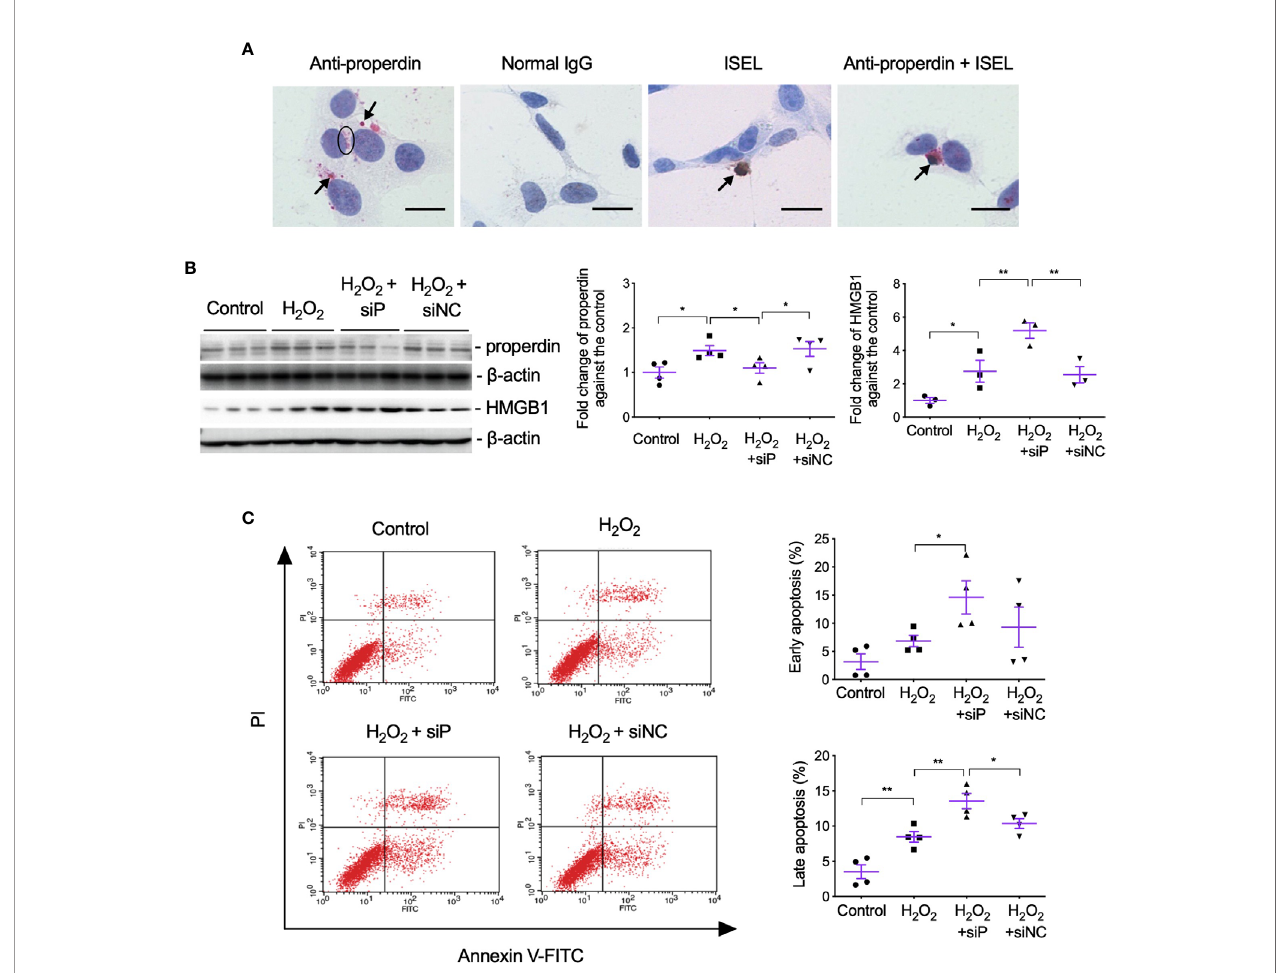
FIGURE 6 | Properdin tagged apoptotic TCMK-1 cells and inhibiting properdin increased apoptotic cells and HMGB1 expression in H 2 O 2 -treated TCMK-1 cells. (A) Properdin protein was visualized in TCMK-1 cells after H 2 O 2 treatment for 24 h (indicated by a circle and two arrows nearby), in which the staining of properdin was negatively controlled by normal rabbit IgG. ISEL+ apoptotic TCMK-1 cells and its colocalization with properdin protein were also seen (pointed by another two arrows, n = 3). Scale bar: 5 m m. (B) The expression of properdin and HMGB1 detected by Western blot was increased by H 2 O 2 treatment for 24 h, whereas siP reduced properdin expression but increased HMGB1 (n = 3). (C) The early and late apoptotic TCMK-1 cells detected by fl ow cytometry analysis were both increased by H 2 O 2 treatment for 24 h and furthered by siP (n = 3). FITC fl uorescein was tagged to Annexin V, thus can reveal the binding of Annexin V to the cellular surface of apoptotic cells that exposed phosphatidylserine (PS). Propidium iodide (PI) passed leaky necrotic cells to stain the DNA. Data were shown as means ± SEMs and analyzed by one-way ANOVA and LSD test. siP, siRNA targeting properdin; siNC, negative control siRNA. * p < 0.05; ** p <